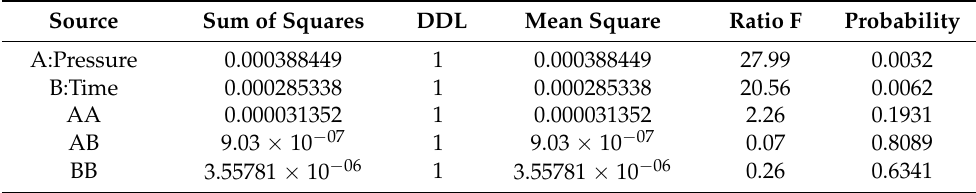
Table 6. Analysis of variance for Starting_accessibility-MANGO.